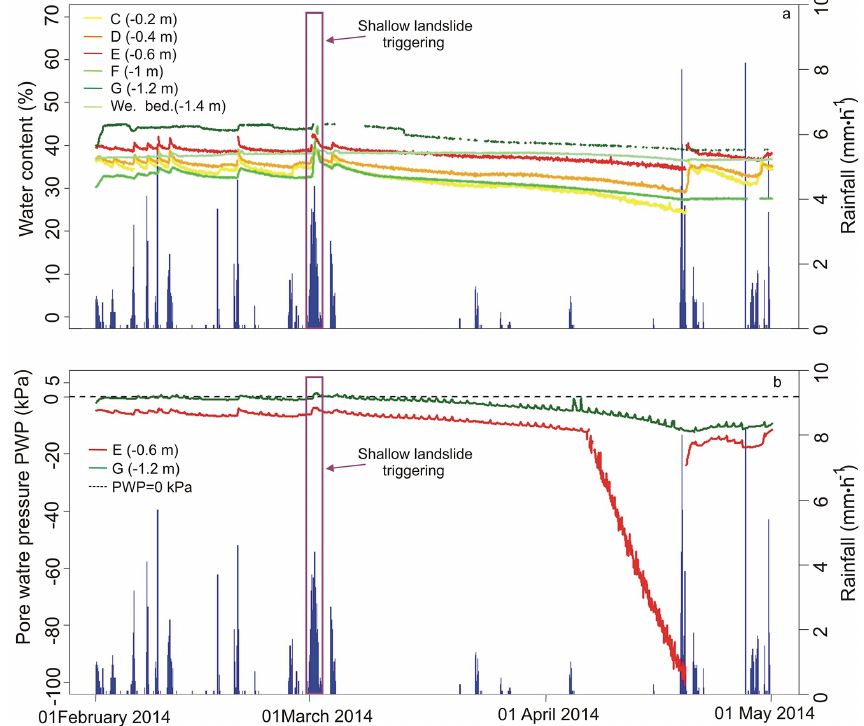
Figure 7. Monitored soil and weathered bedrock water content (a) and pore water pressure dynamics (b) at the monitored test-site slope between 1 February and 1 May 2014.